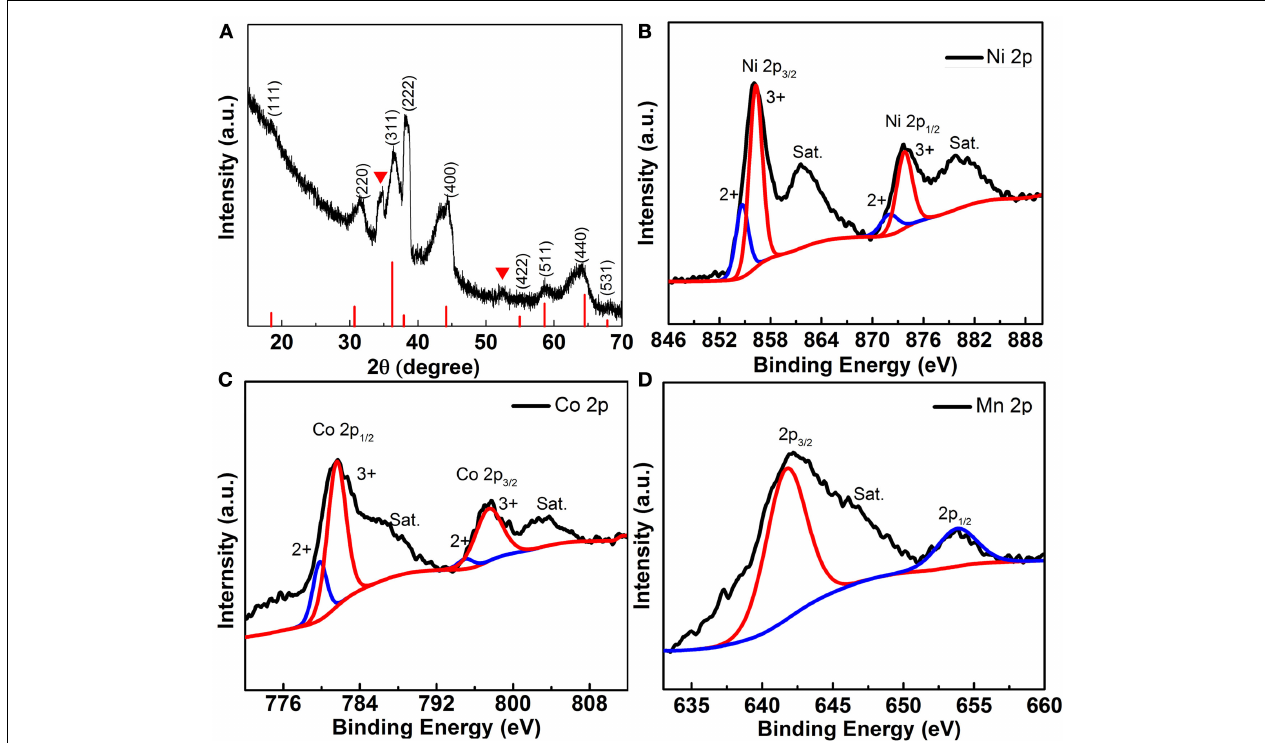
FIGURE 3 | (A) XRD pattern of Ni–Co–Mn oxide nanoneedles grown on Ni Foam. High-resolution XPS of (B) Ni 2p, (C) Co 2p, and (D) Mn 2p.